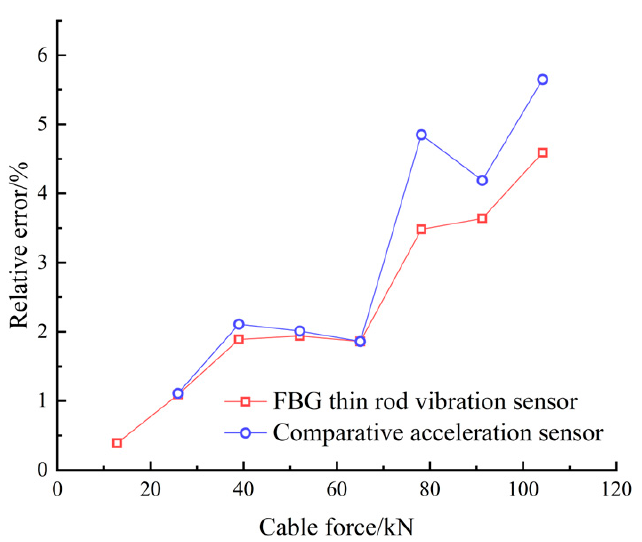
Figure 10. The error of the two sensors in identifying the actual cable force of the cable.